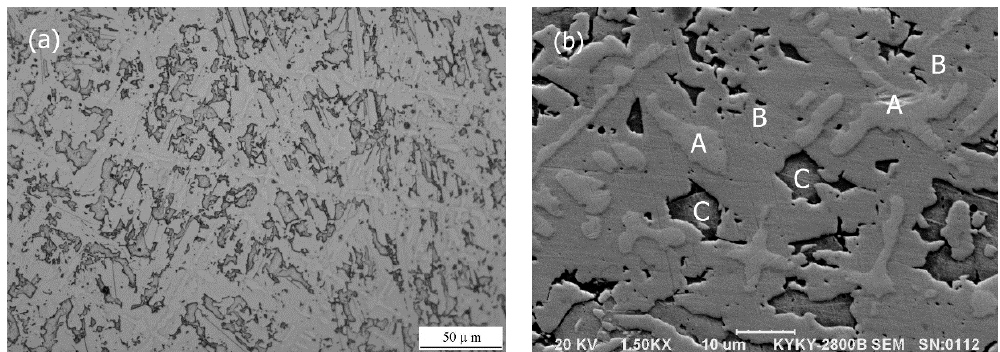
Figure 3. Low magnification optical microscope (OM) ( a ) and high magnification scanning electron microscope (SEM) ( b ) micrographs showing typical microstructure morphologies of the Mo–40Ni–13Si alloy. Table 1. EDS results of individual phase in the Mo–40Ni–13Si alloy.